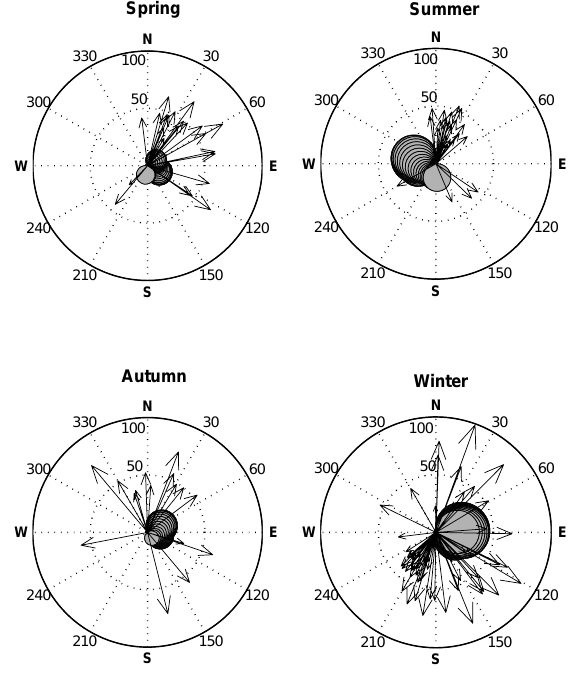
Fig. 8. The magnitude (denoted by arrow length) and direction (denoted by arrow direction) of the gravity waves horizontal phase speed during each season. The values in radial direction represent the speed (ms − 1 ) in each direction. The superimposed area gives “Blocking diagram” for each season from 20 to 85km height. The wind profiles data for each season from HWM-07 model (averaged from 20:00 to 04:00LT for each season).